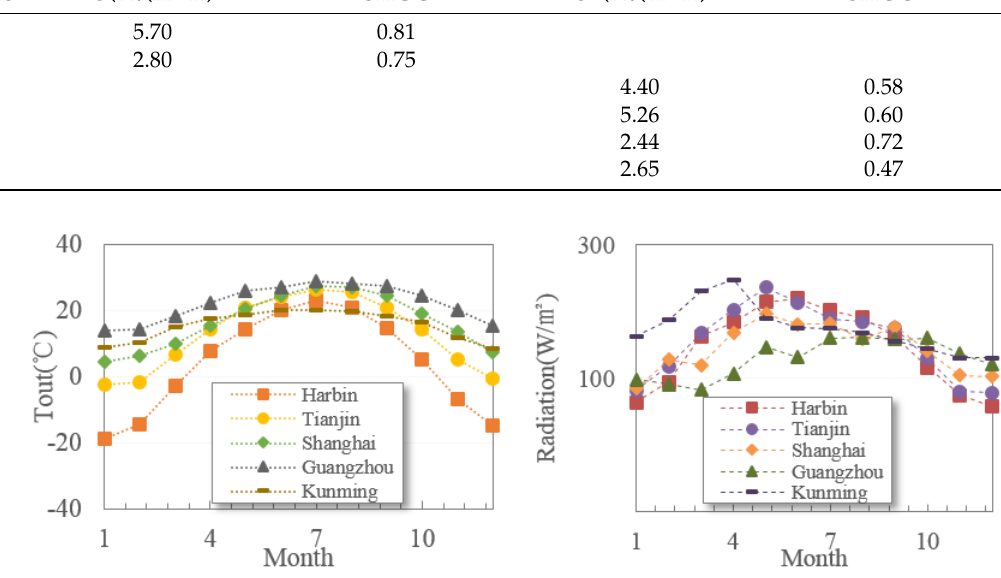
Figure 7. The monthly temperature and solar radiation intensity of the representative cities.